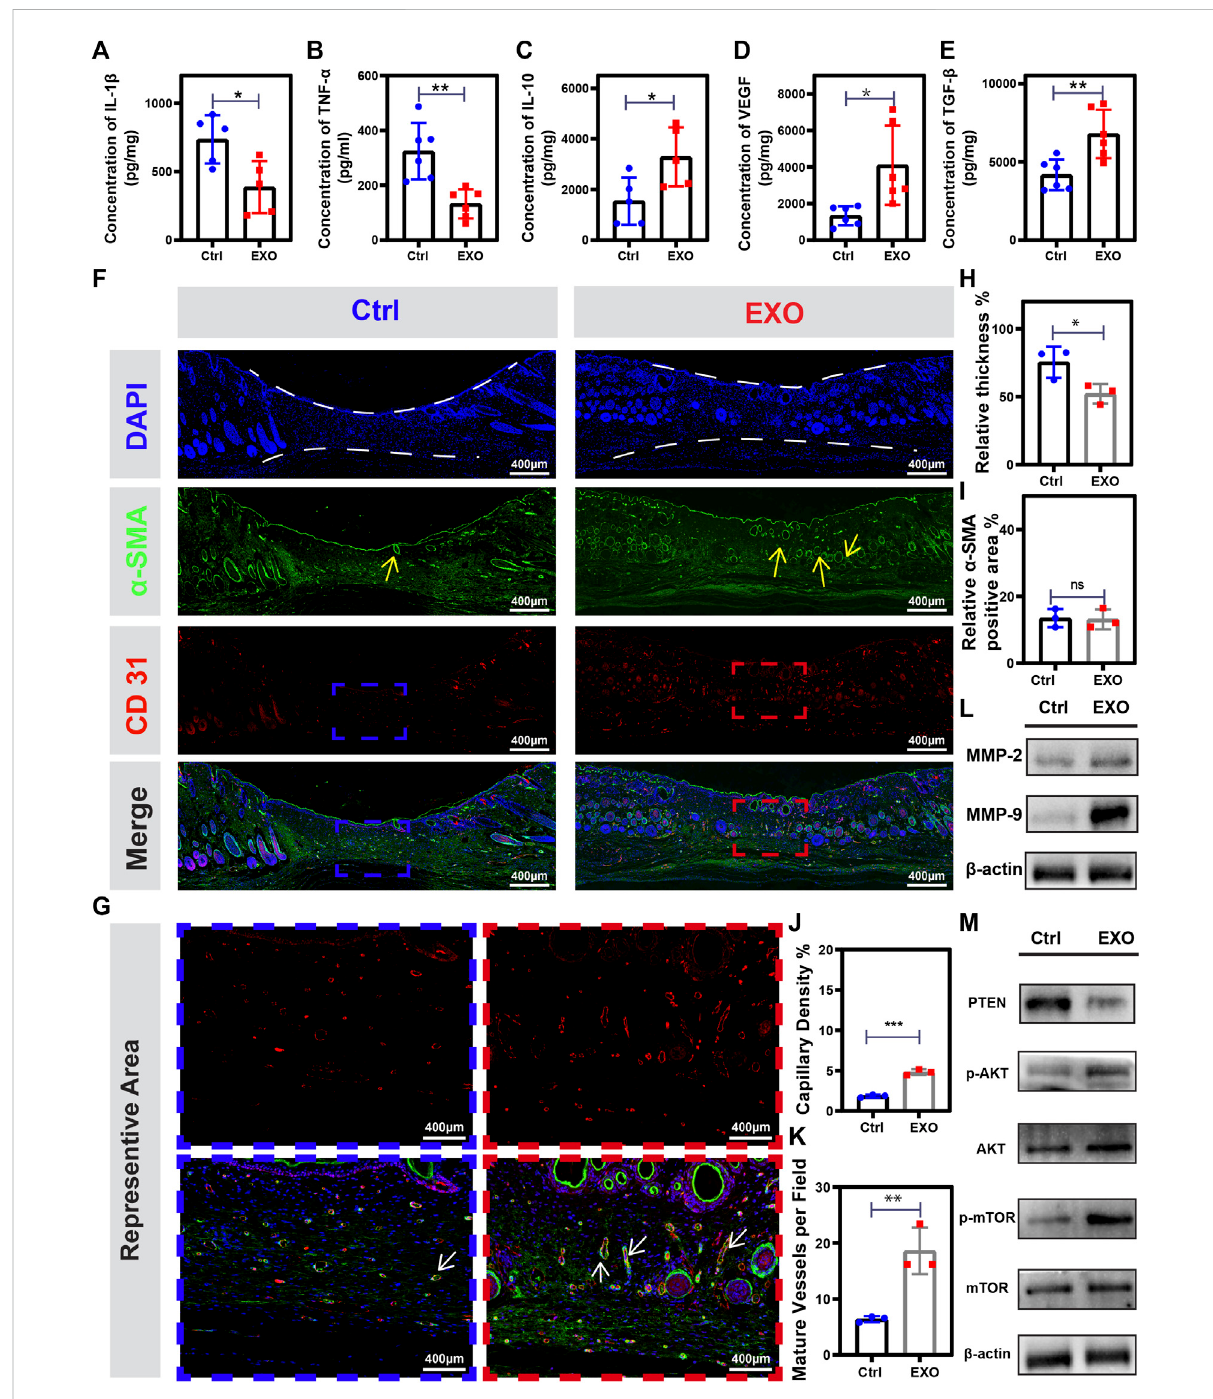
FIGURE 7 M2-EXOtreatmentpromotesangiogenesisandtissueregenerationinthewound. (A – E) ELISAassayusedtotestTNF- α ,IL-1 β ,IL-10,TGF- β ,and VEGFconcentrationinonthe7thday.( n =6). (F) Immune- fl uorescenceimageswerecollectedfromtissuehomogenizationonthe14thdayfromthe control group, and the M2-EXO treated group, respectively. Red dye was used to label CD31; Green dye was used to label α -SMA; DAPI was used to label the nucleus; Merge fi gure was presented by integrating all the fi gures. Scale bar was labeled in the fi gures. (G) Representative immuno fl uorescence fi gures selected from (F) followed by being enlarged. (H) Quanti fi cation analysis of the relative thickness of granulation tissue ( n = 3). (I) Quanti fi cation analysis of α -SMA-positive staining area ( n = 3) (J) Quanti fi cation analysis of vessel density in sarcomeres ( n = 3) (K) Quanti fi cation analysis of the number of mature blood vessels in sarcomeres ( n = 3). (L – M) Western blot was used to test the expression level of MMP-2, MMP-9, PTEN, p-AKT, AKT, mTOR, and p-mTOR in tissue homogenization collected on the 7th day. Data was expressed as mean ± 3 σ ; * = signi fi cant, * p < 0.05; ** p < 0.01,*** p < 0.005; **** p < 0.001, Student t